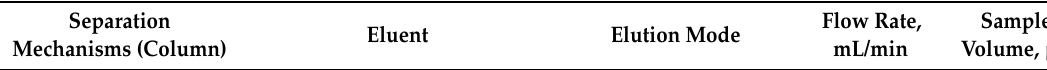
Table 5. Chromatographic conditions